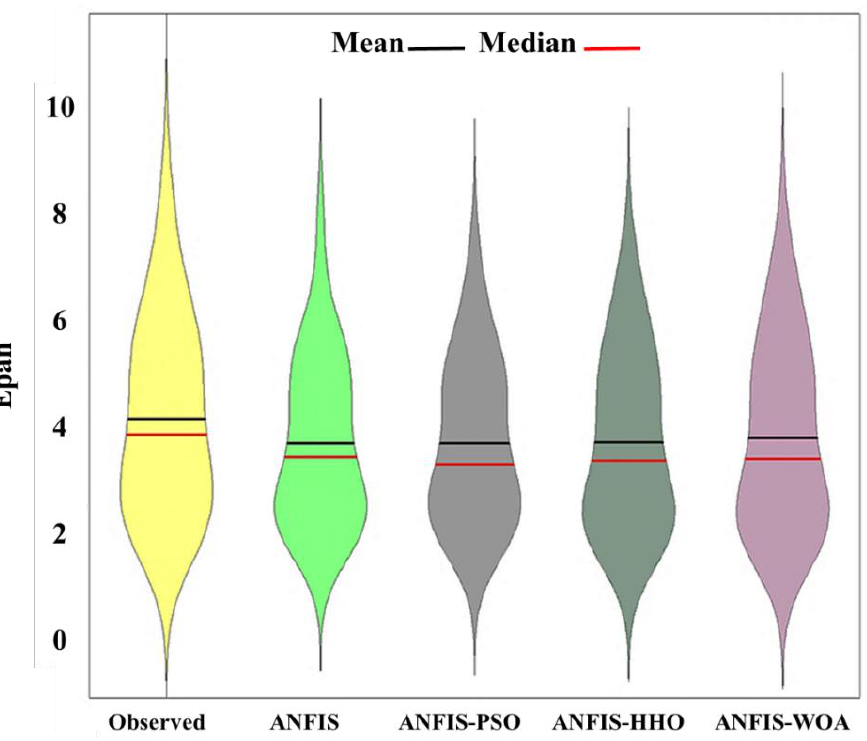
Figure 7. Violin plots of the predicted Epan using the hybridized ANFIS models in the testing phase using the best input combination — Nanxian Station.